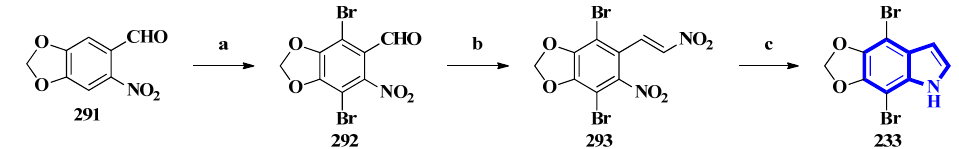
Figure 18. The total synthesis of amakusamine 233 . (a) NBS, conc. H 2 SO 4 , 63%; (b) (1) Al 2 O 3 , CH 3 NO 2 and (2) Ac 2 O; (c) Iron in AcOH, (last two steps) 89%.